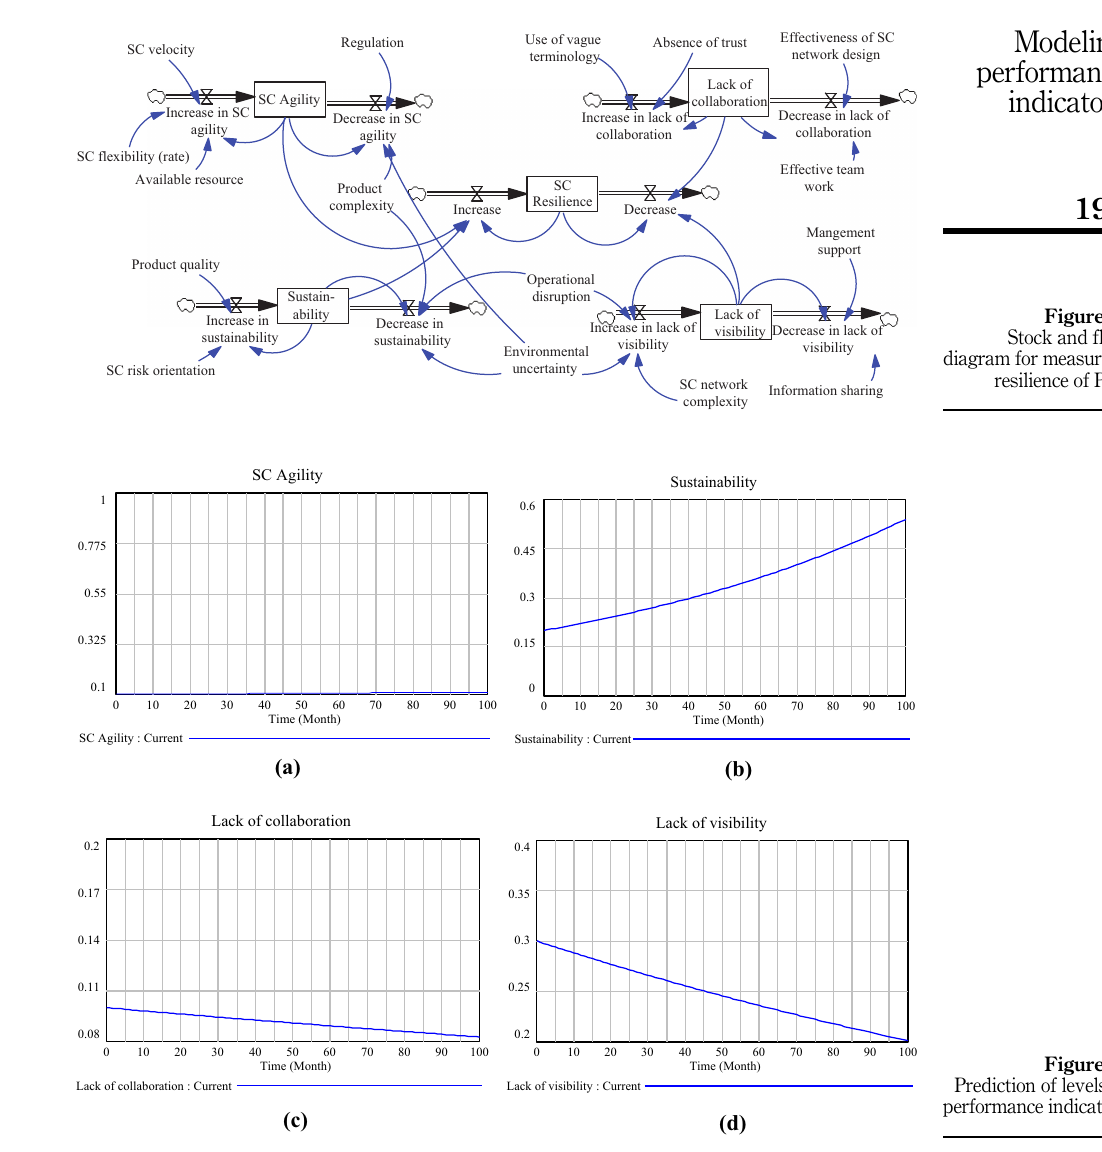
Figure 5. Prediction of levels of performance indicators